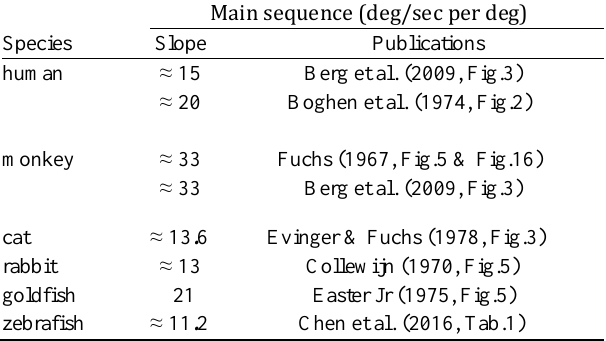
Table 1. The linear regression slopes of the main sequence of diverse animal species. The slopes are either the reported re- sults (averaged if multiple) or our approximations based on the figures (only considering the results of saccades ≤ 20 °) in the studies.